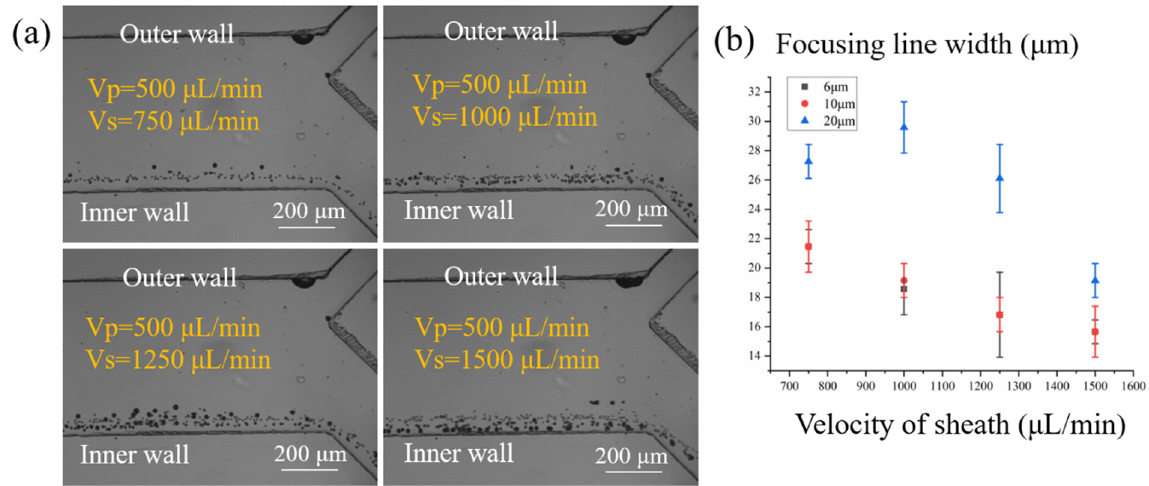
Figure 5. ( a ) Focusing performance of the microspheres with diameters of 6, 10, and 20 µ m under a range of velocities; ( b ) the focusing line width was used to evaluate the focusing efficiency of different particles.